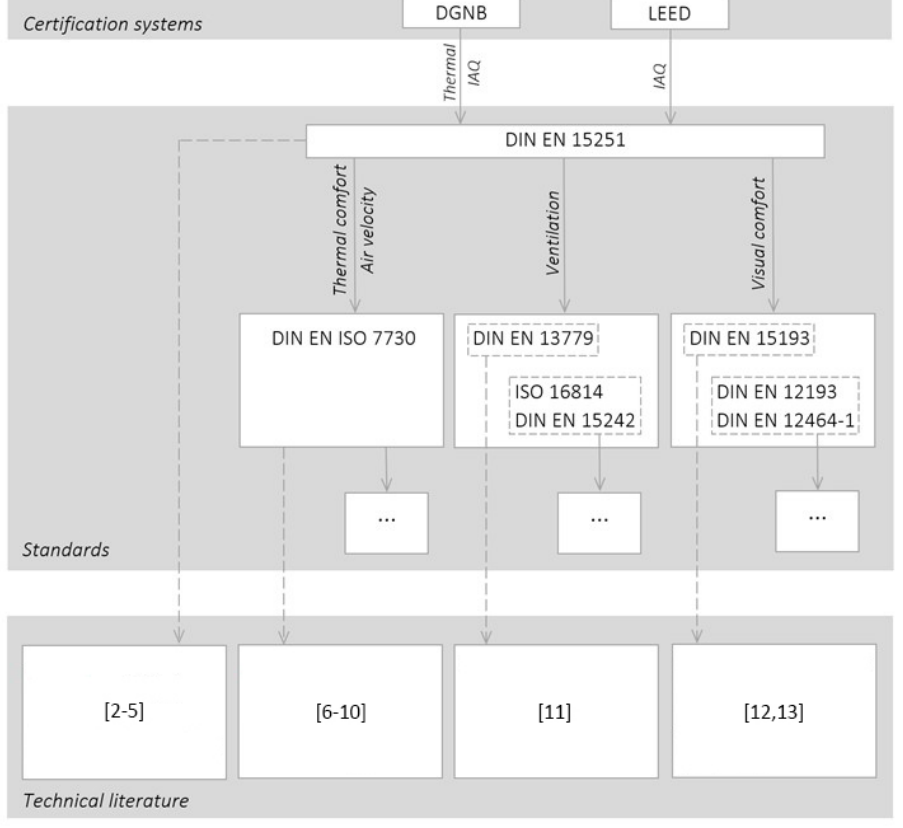
Figure 1. Illustrative exemplification of the chain of reference from certification systems, to different layers